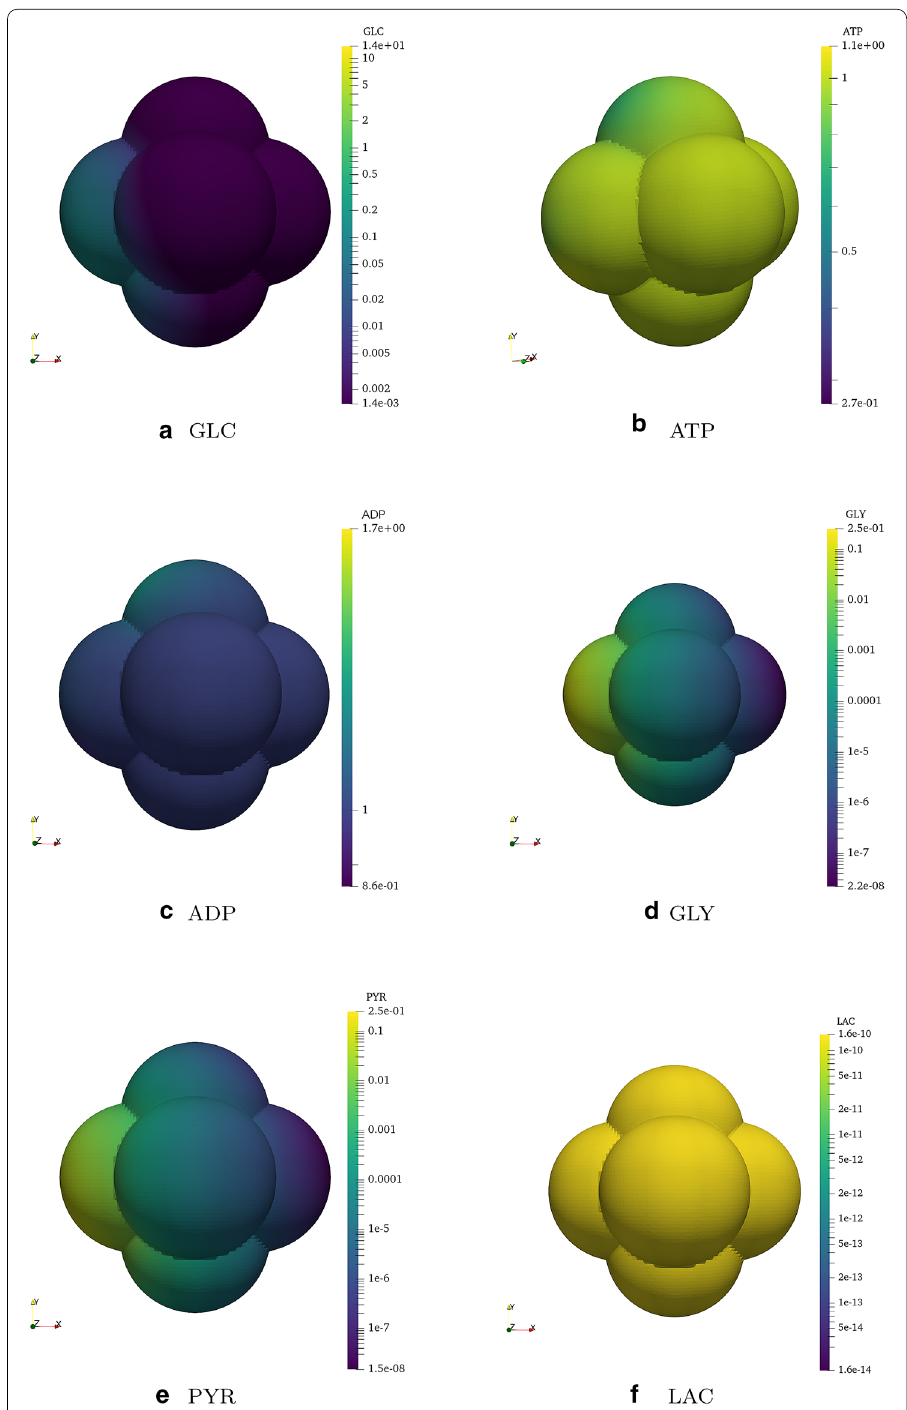
Fig. 13 Solution of the reaction–diffusion system at time t = 5 solved using CutFEM inside a 3 dimensional pop corn shape. From top to bottom from left to right [GLC], [ATP], [ADP], [GLY], [PYR], [LAC]. The GLC is diffusing into the domain starting from the influx location. ATP and ADP are consumed and produced by the reaction act. GLY is produced by HXK and PYR produced by